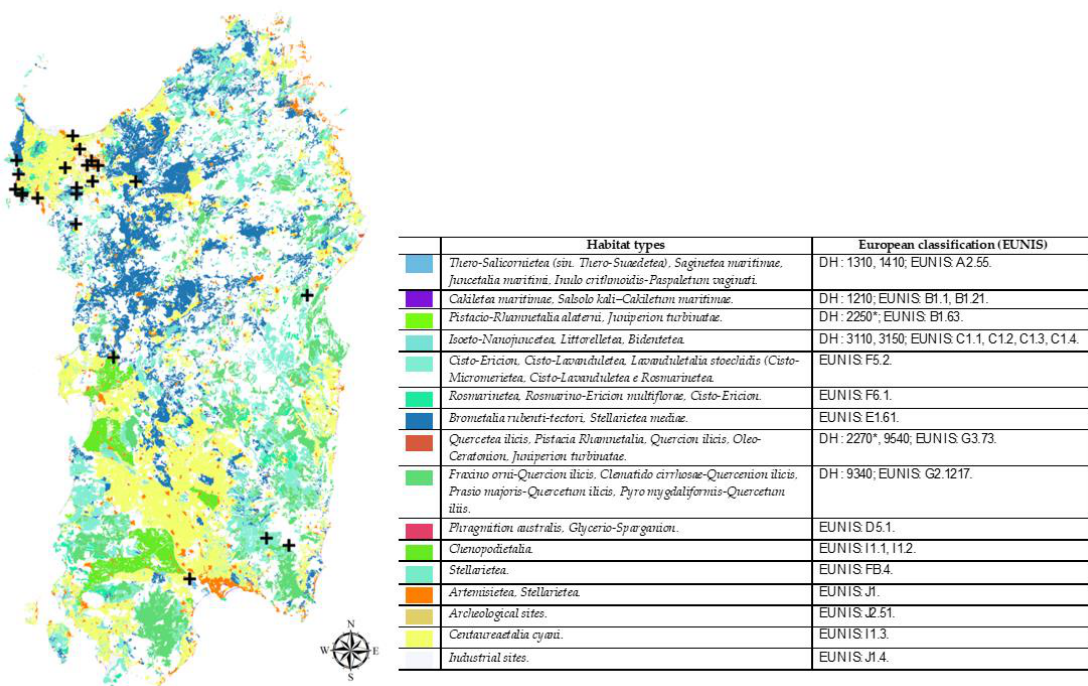
Figure 2. Mapping of habitats present in Sardinia [36,37] and sampling sites ( ) where the new Apoidea were recorded.